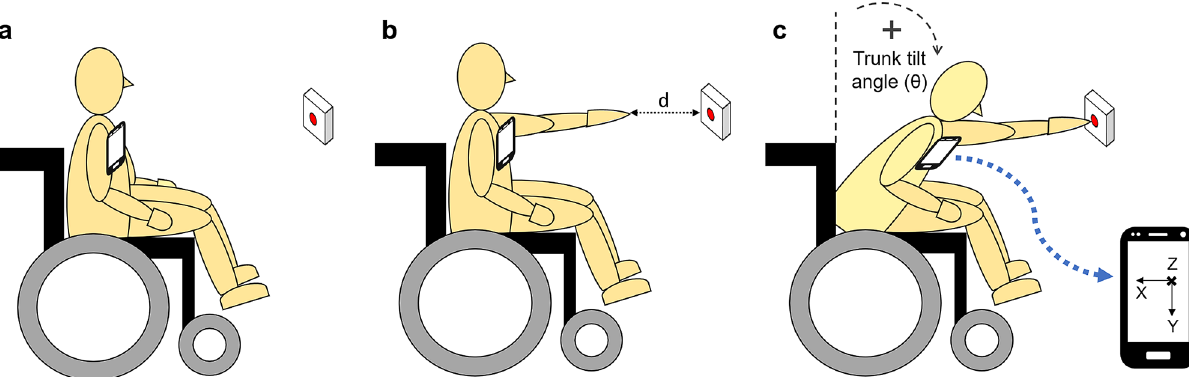
Figure 1. Schematic representation of the subject’s task. The subject is sitting in a wheelchair, and the initial position is at rest, with the arms on the chair’s armrests ( a ), at a distance ‘d’ (15 cm or 30 cm) from the target switch button ( b ). Following a go-signal, the subject raises the left arm and bends the trunk forward to press the button ( c ). A smartphone is attached to the subject’s thorax to collect accelerometer data. The X, Y, and Z directions of the accelerometer are